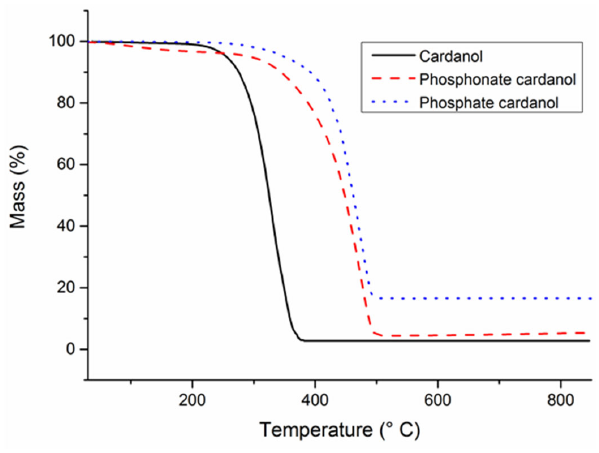
Figure 3. TGA thermograms of cardanol, phosphonate ‐ cardanol and phosphate ‐ cardanol.